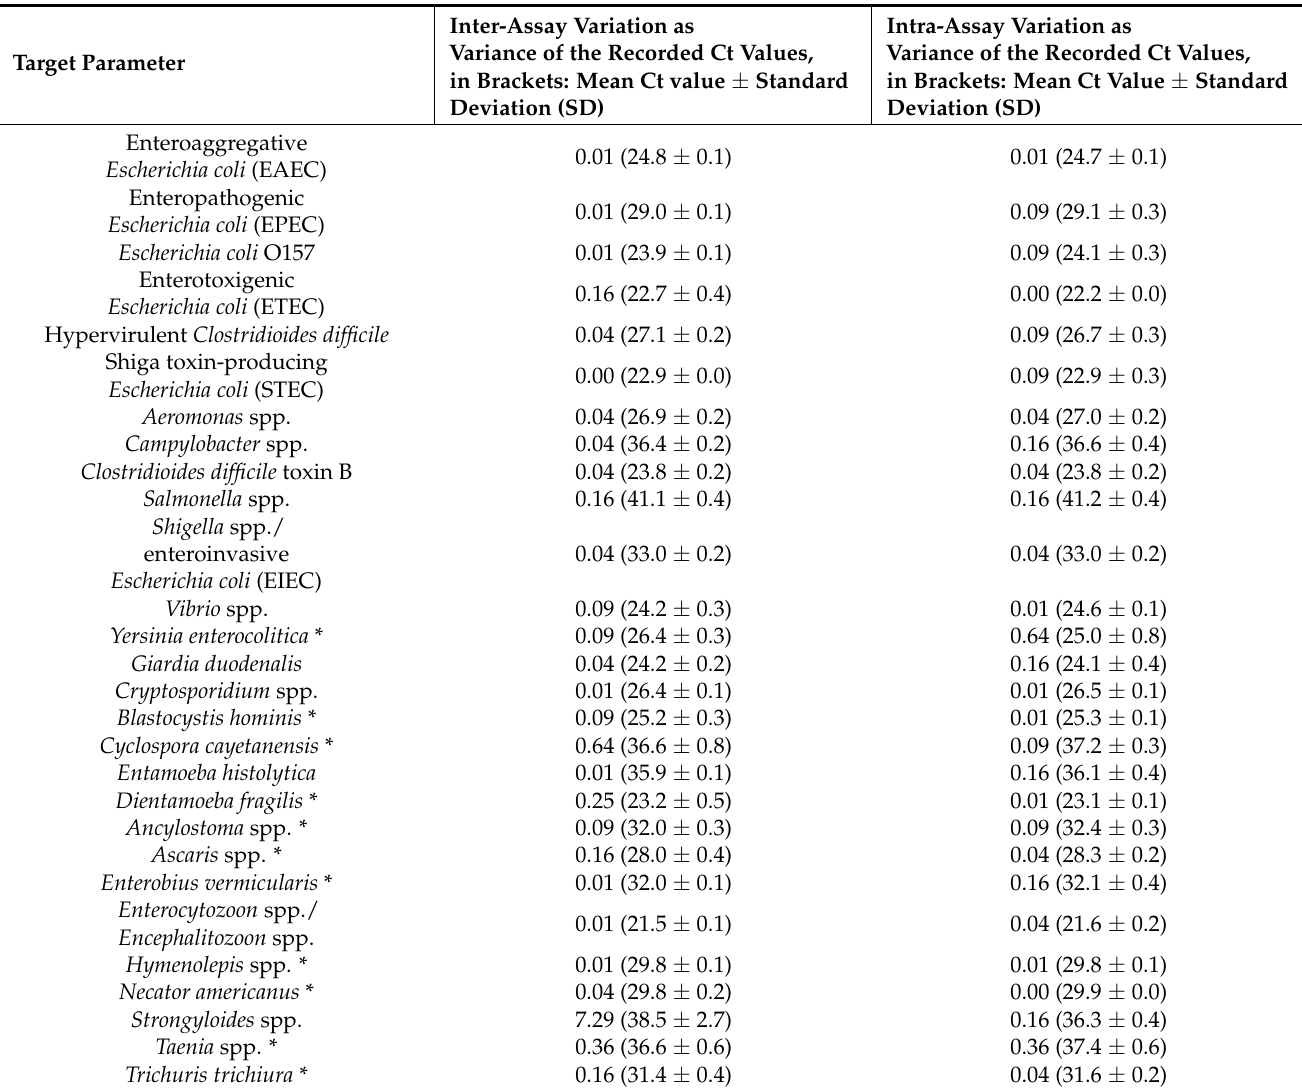
Table 3. Intra- and inter-assay variations assessed with the same sample per parameter of the Allplex assays. For target parameters indicated by an asterisk (*), insufficient residual stool volumes of positive samples were available, so residual DNA from previous nucleic acid extractions had to be used for the